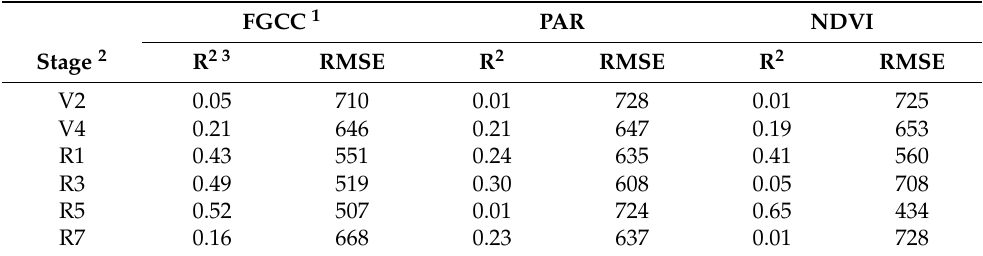
Table 3. Coefficients of determination (R 2 ) of soybean seed yield in relation to green canopy cover, light interception, and a vegetative index sampled at various growth stages for Casselton, Prosper, and Fargo, North Dakota, USA, in 2019 and